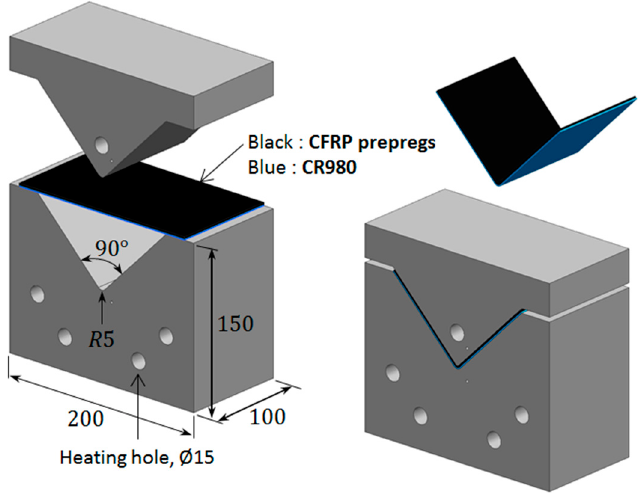
Figure 1. V-bending die for manufacturing hybrid composites of CFRP prepregs and CR980 metal plate.